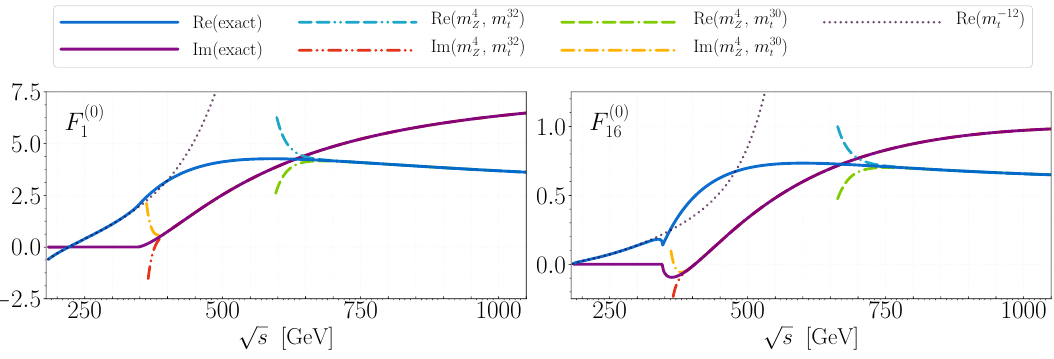
Figure 2 . The LO form factors of the tensor structure T 1 and T 16 as a function of p s , plotted for (cid:18) = (cid:25)= 2. Both the real and imaginary parts are shown. Solid, dash-dotted and dotted lines correspond to the exact, high-energy and large- m t